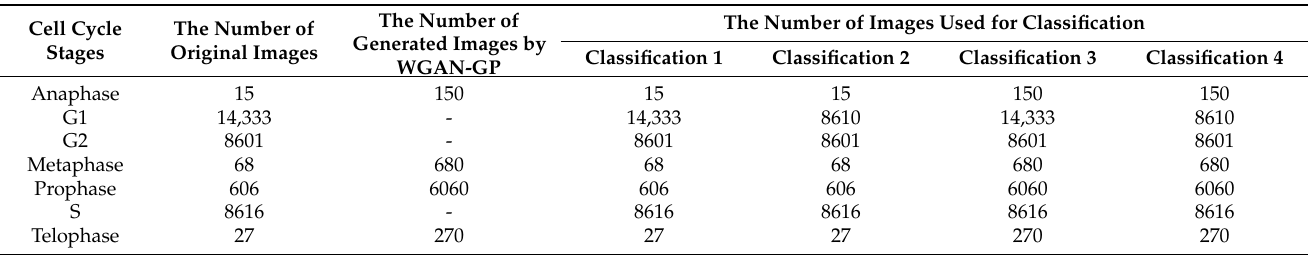
Table 1. The number of images of different cell cycle stages and the number of images used for seven stages. Cell Cycle The Number of Stages Original Images